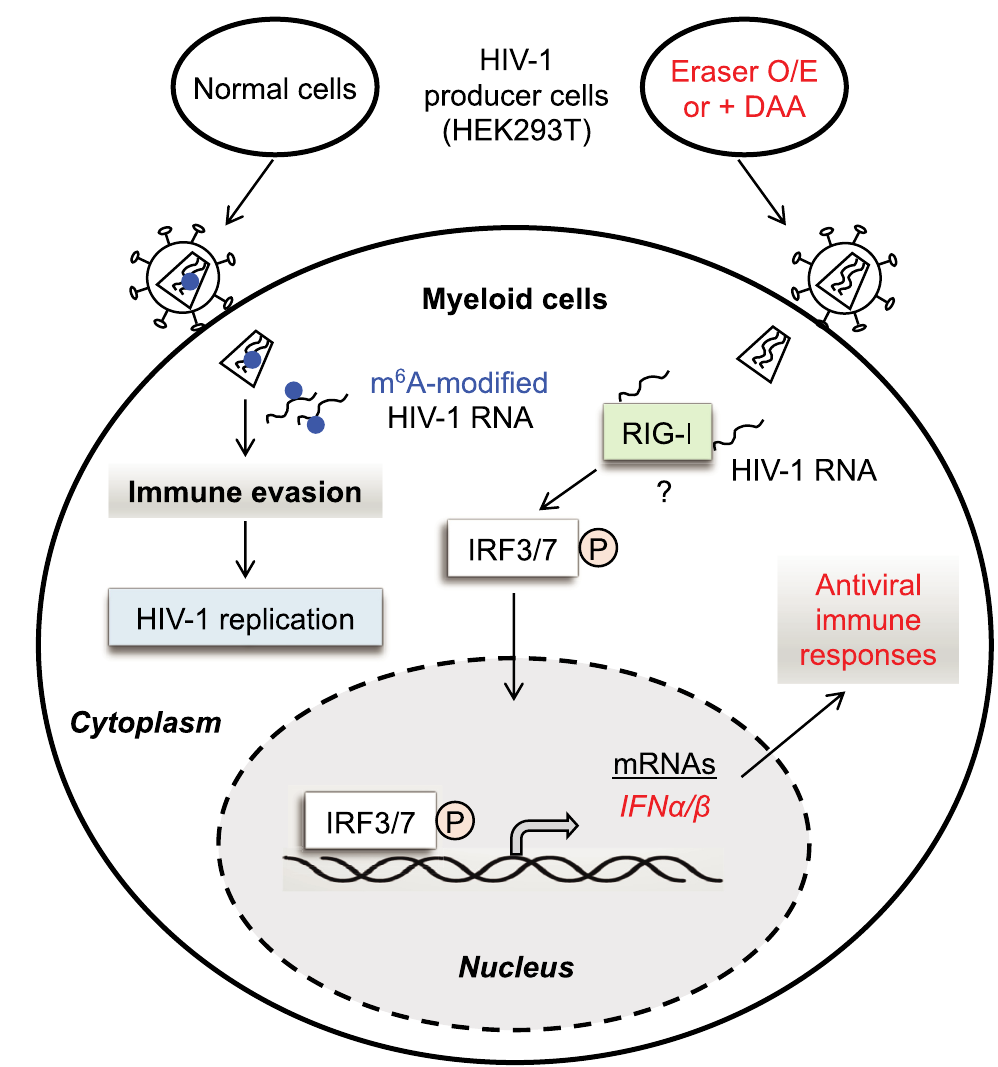
Fig 12. HIV-1 RNA escapes from innate immune surveillance in myeloid cells. In HIV-1 producer cells, writers add and erasers remove internal m 6 A modifications (blue dots) of viral RNA, respectively. HIV-1 with m 6 A-modified RNA avoids innate sensing in infected myeloid cells, thereby escaping immune surveillance. Overexpression (O/E) of erasers or inhibiting m 6 A addition with DAA in HIV-1 producer cells generates viruses with m 6 A-deficient viral RNA. When HIV-1 with m 6 A-deficient RNA infects myeloid cells including macrophages, the cytoplasmic RNA sensor RIG-I recognizes unmodified HIV-1 RNA and triggers phosphorylation (indicated by the letter P) of the transcription factors IRF3 and IRF7. Phosphorylation of IRF3/7 leads to IFN- α / β expression and generates antiviral innate immune responses in HIV-1-infected macrophage-like cells. However, it remains to be established whether m 6 A-deficient HIV-1 RNA enhances binding to RIG-I, thereby inducing IRF3/7 activation and IFN-I expression in